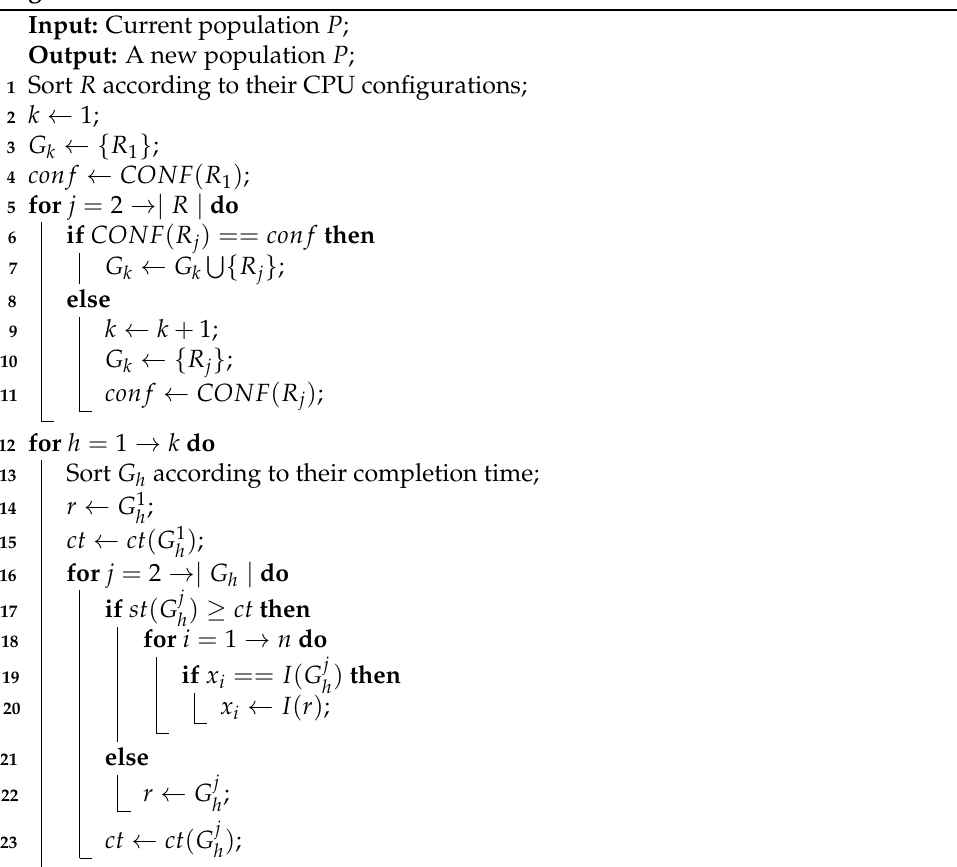
Algorithm 2: Function